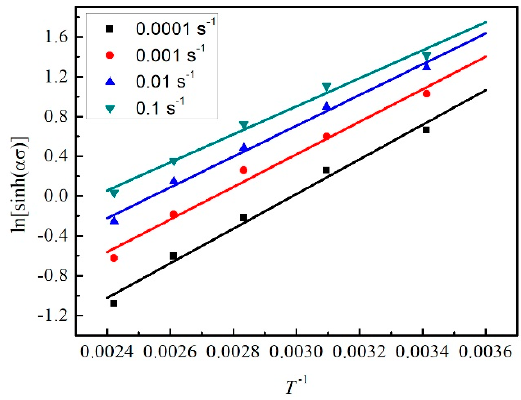
Figure 15. The relation between ln[sinh( ασ )] and 1/ T at the strain of 0.3.